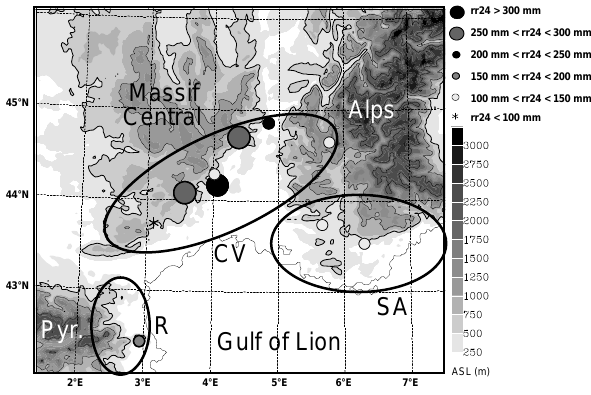
Fig. 2. Location and intensity of the maximum daily precipitation (rr24, top right legend) simulated with HRA2.5 for all the studied cases. The orography is displayed in grey scale (bottom right legend) with a bold solid contour at 500m and a thin contour at 1m (coastline), 1000m and 2000m. The names of the main mountain ranges and of the the regions affected by the HPEs are also given. Pyr. stands for the Pyrenees, CV for the C´evennes-Vivarais region, R for Roussillon and SAfor Southern Alps.